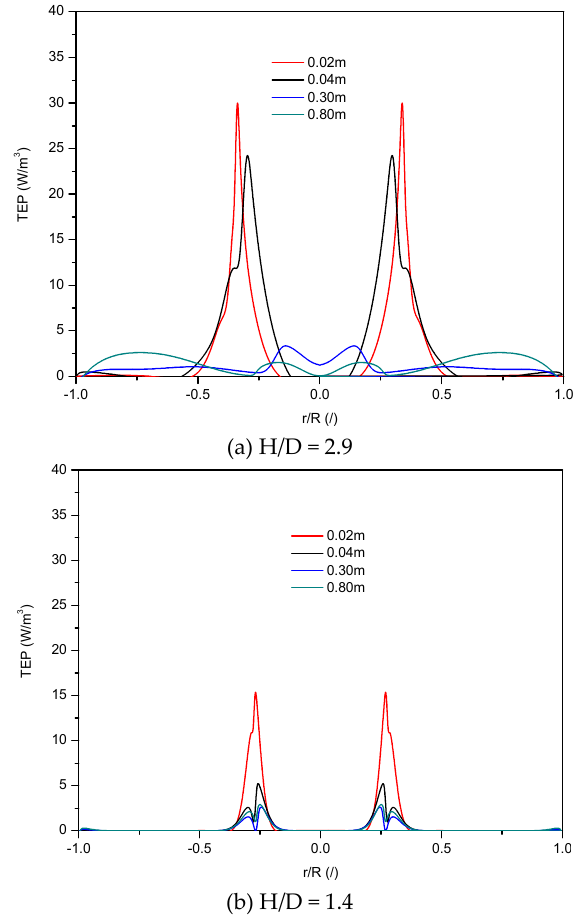
Figure 9. Distributions of two-phase turbulent energy production values near the inlet region and fully developed region using two jetting holes (rjet/R = ±0.36), H/D = 2.9 and H/D = 1.4.